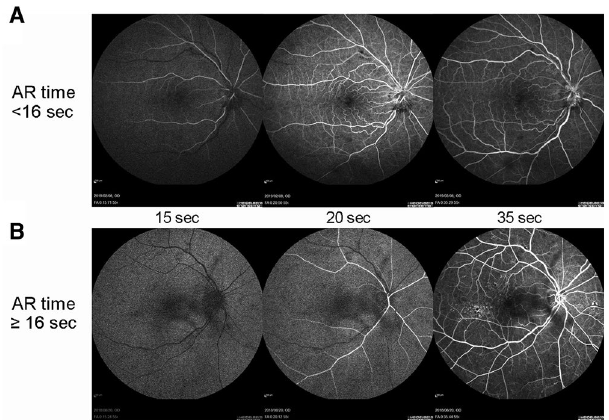
Figure 2. Representative images of fluorescein angiography of eyes with arm-to-retina (AR) time < 16 s and ≥ 16 s. ( A ) Images of the eye of an 80-year-old woman with AR time 13.3 s (best-corrected visual acuity [BCVA], 0.398 at 12 months; increase in central retinal thickness (CRT), 393 μm at 12 months compared with baseline). ( B ) Images of the eye of a 86-year-old woman with AR time 17.7 s (BCVA, 0.000 at 12 months; reduction in CRT, 186 μm at 12 months compared with baseline). FA images 15, 20, and 35 s after the time point that the dye reached the injection inserted point are